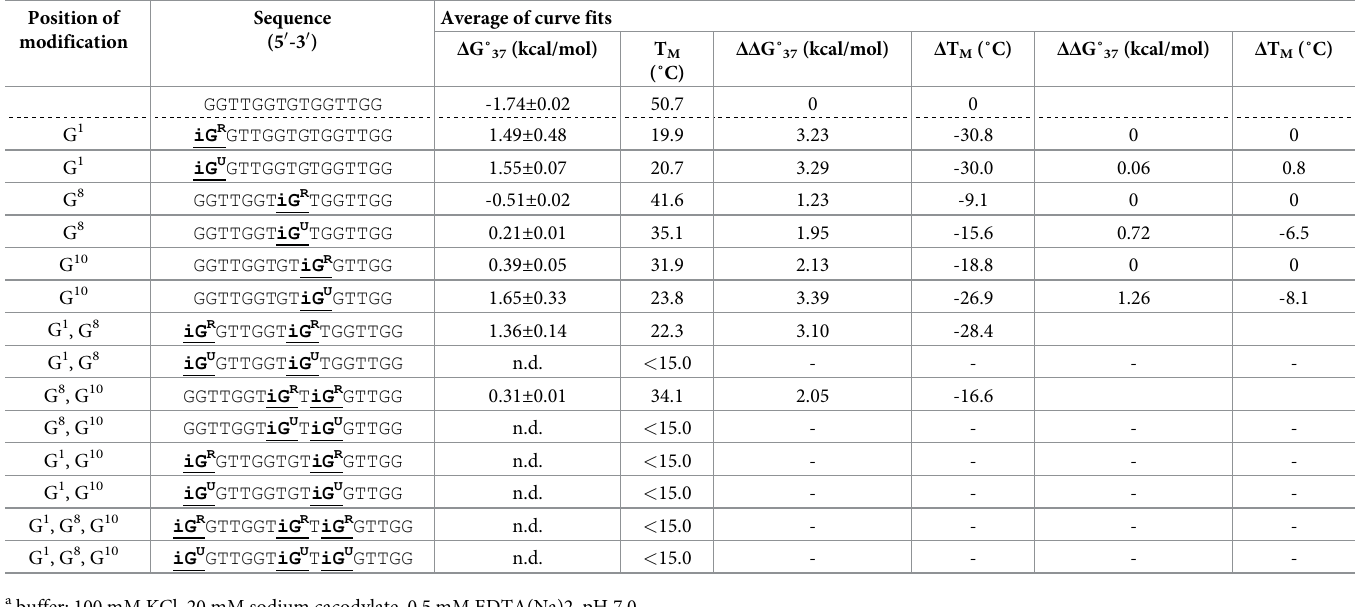
n.d.–not determined, detailed thermodynamic analysis is presented in S3 Table